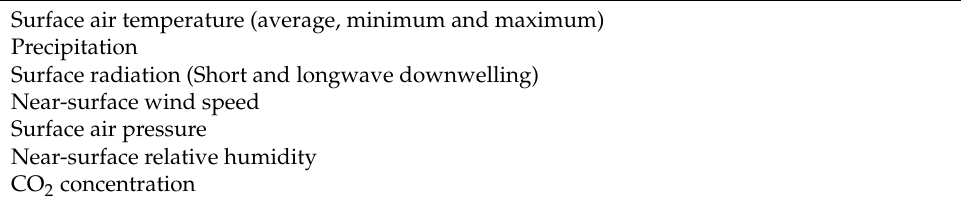
Table 3. The climate parameters involved in ISI-MIP climate